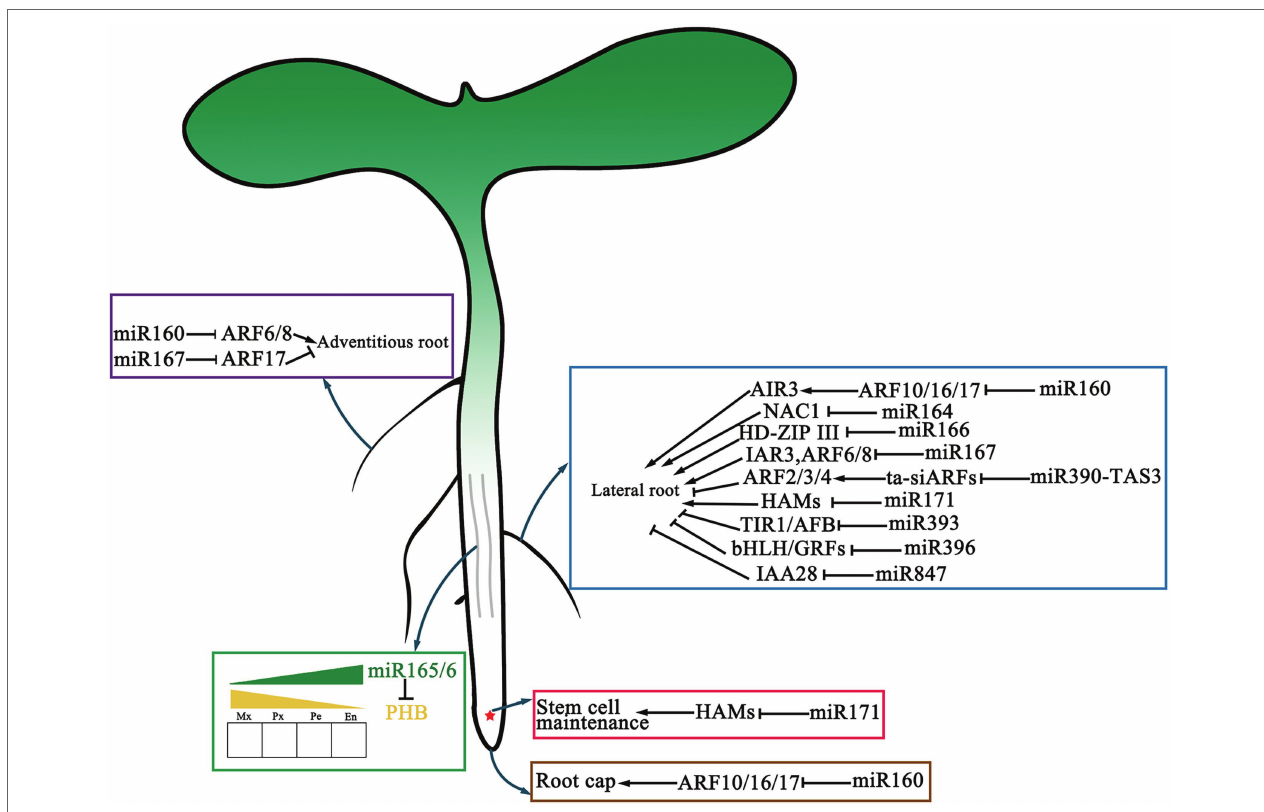
FIGURE 3 | The function of miRNAs in the development of vascular and root. microRNAs are involved in vascular and root development. All of the mRNAs with verified functions in main root, lateral root, adventitious root development as well as their respective main targets are represented. The red asterisk represents the quiescent center (QC). The solid gray line in the middle of the main root represents the vascular